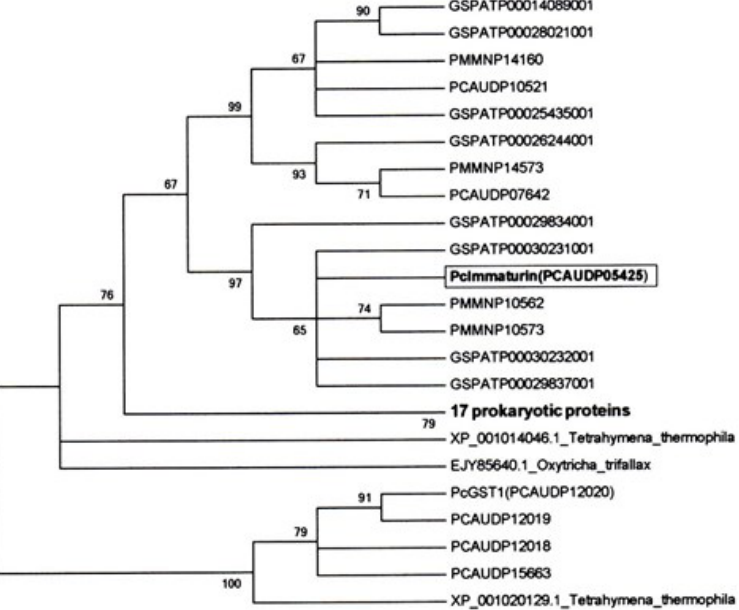
Figure 5. The maximum likelihood (ML) consensus tree of immaturin. A phylogenetic tree was generated from bootstrap analysis with 1000 replications of immaturin and its orthologs based on amino acid sequence alignment shown in Figure S1. Species names are indicated with the protein IDs used in the Paramecium DB or GenBank accession numbers. Pc, Pt, Pm, Tt, and Ot are abbreviations of Paramecium caudatum , P. tetraurelia , P. multimicronucleatum , Tetrahymena thermophile, and Oxtricha trifallax , respectively. Bootstrap values > 60% are given to the left of the selected nodes. Branches with less than 50% of bootstrap replicates are collapsed. Seventeen prokaryotic orthologs are compressed and shown as a single node.